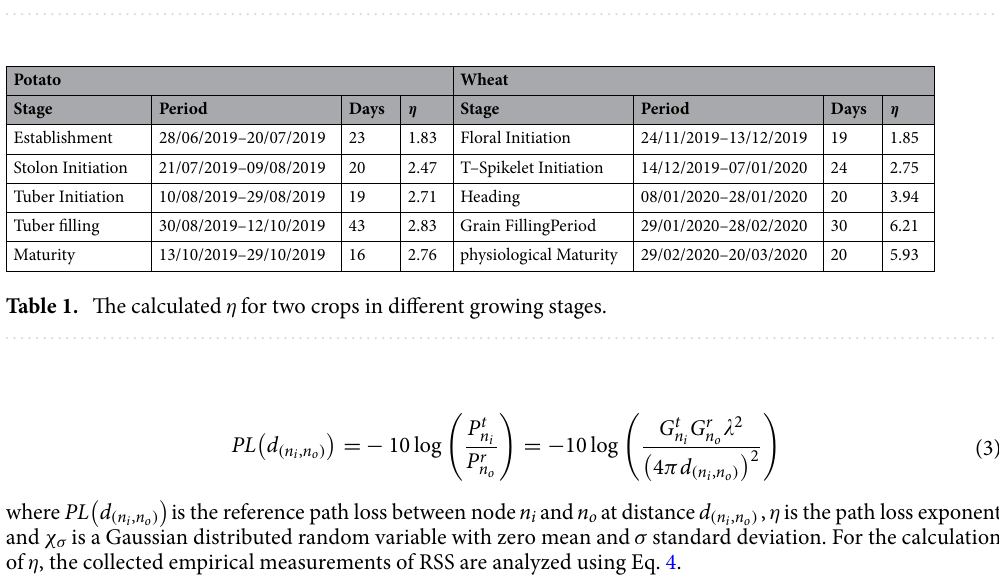
Figure 2. Latitude,longitude representation and RSS measurement in T wheat . MATLAB 2016a. https:// in. mathw orks. com/.